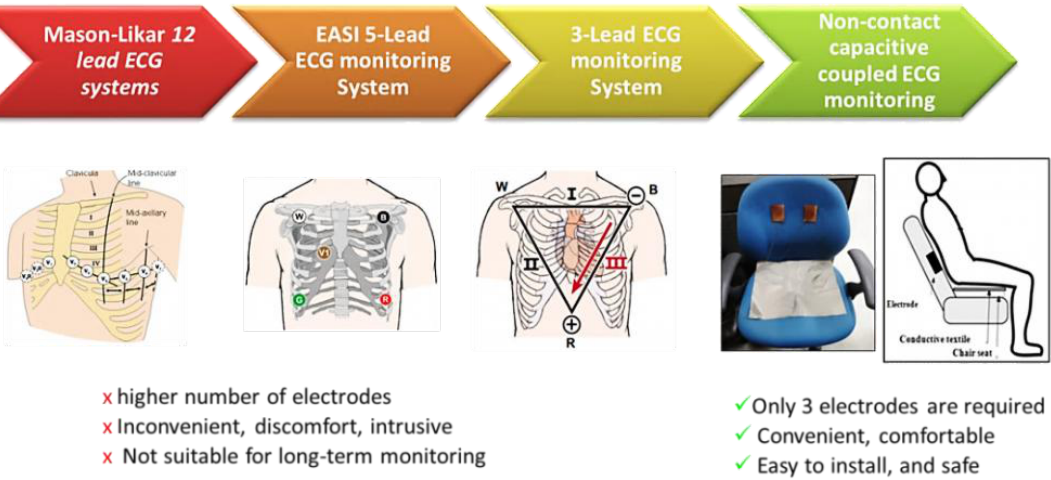
Figure 1. Comparison between the conventional and noncontact capacitive-coupled ECG measurement methods.